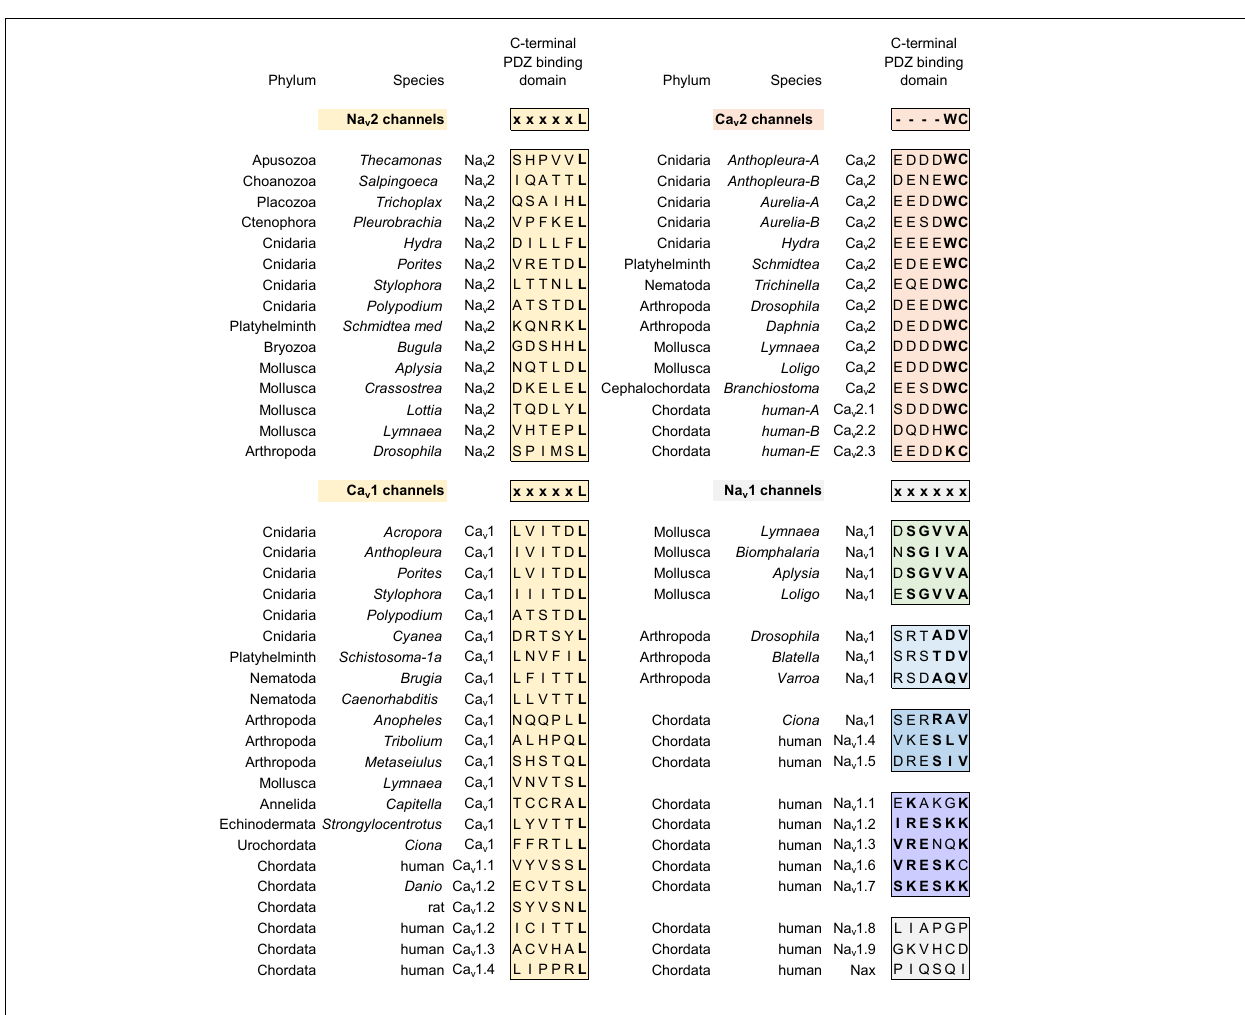
FIGURE 12 | Alignment of amino acid sequences coding for the C-terminal ends of calcium channels (Ca v 1 and Ca v 2) and sodium channels (Na v 2 and Na v 1) where there are conserved sequence motifs associated with binding to different classes of PDZ domain containing proteins. There is a surprising consistency in a xxxxL motif conserved between Na v 2 and Ca v 1 channels (yellow color), both of which constitute the basal complement of high voltage-activated calcium channels and sodium channels present in genomes of single cell choanoflagellates such as S. rosetta . The Na v 1 and Ca v 2 channels, which are likely derived from Na v 2 and Ca v 1 channels, respectively, possess different sets of PDZ binding domain motifs (denoted by orange, green, blue, purple colors). PDZ binding motifs uniquely diverge within the Na v 1 channel class where molluscan, arthropod, and different human sodium channels associate with separate classes of PDZ domain containing proteins, contributing to their specific localization within their unique cellular environments. The “SLV/SIV” C-terminal PDZ binding motif in mammalian Na v 1.4 and Na v 1.5, for example, aids in the complexing of these Na v 1 channels to syntrophins and SAP97, for the cellular targeting within skeletal and cardiac muscle, respectively. Ca v 3 channels lack conservation in a C-terminal PDZ domain. Amino acid sequences were aligned using MUSCLE 3.7 (Edgar, 2004) within EMBL-EBI web interface (Chojnacki et al., 2017).